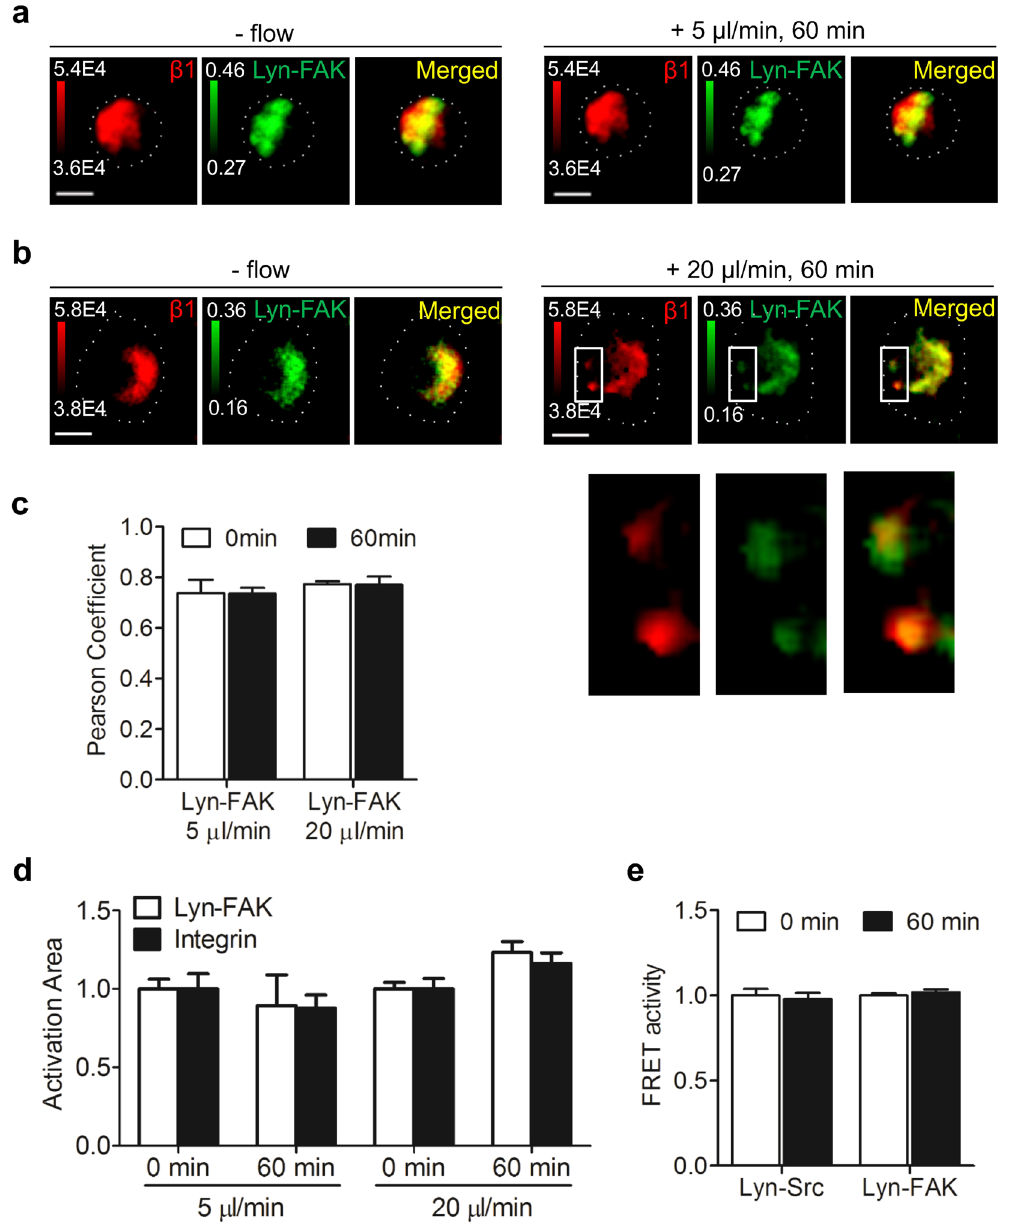
Figure 2. Integrin clustering and Lyn-FAK activity under flow. ( a , b ) The representative images of integrin β 1 and Lyn-FAK activation before and after flow at 5 μ l/min ( a ) and 20 μ l/min ( b ). The integrin β 1 images ( left ), originally 16 bit grayscale, were scaled according to the red colorbar with the thresholded range (see the values in the images). The Lyn-FAK activity images ( middle ) were produced in terms of the FRET ratio, and scaled according to the green colorbar. Merged images ( right ) indicate colocalization of integrin β 1 and Lyn-FAK activation. Scale bars, 10 μ m. ( c ) Pearson correlation coefficients between integrin β 1 localization and Lyn-FAK activation based on the images obtained in ( a,b ). n = 10. ( d ) Changes in integrin β 1 and Lyn-FAK before (0 min) and after (60 min) flow application in terms of area normalized to 0 min. The area was quantified based on the images in ( a,b ). n = 10. ( e ) Lyn-SFK ( n = 9) and Lyn-FAK ( n = 10) activity of the cell pretreated with a function- blocking antibody against β 1 integrins before (0 min) and after (60 min) 20 μ l/min fluid